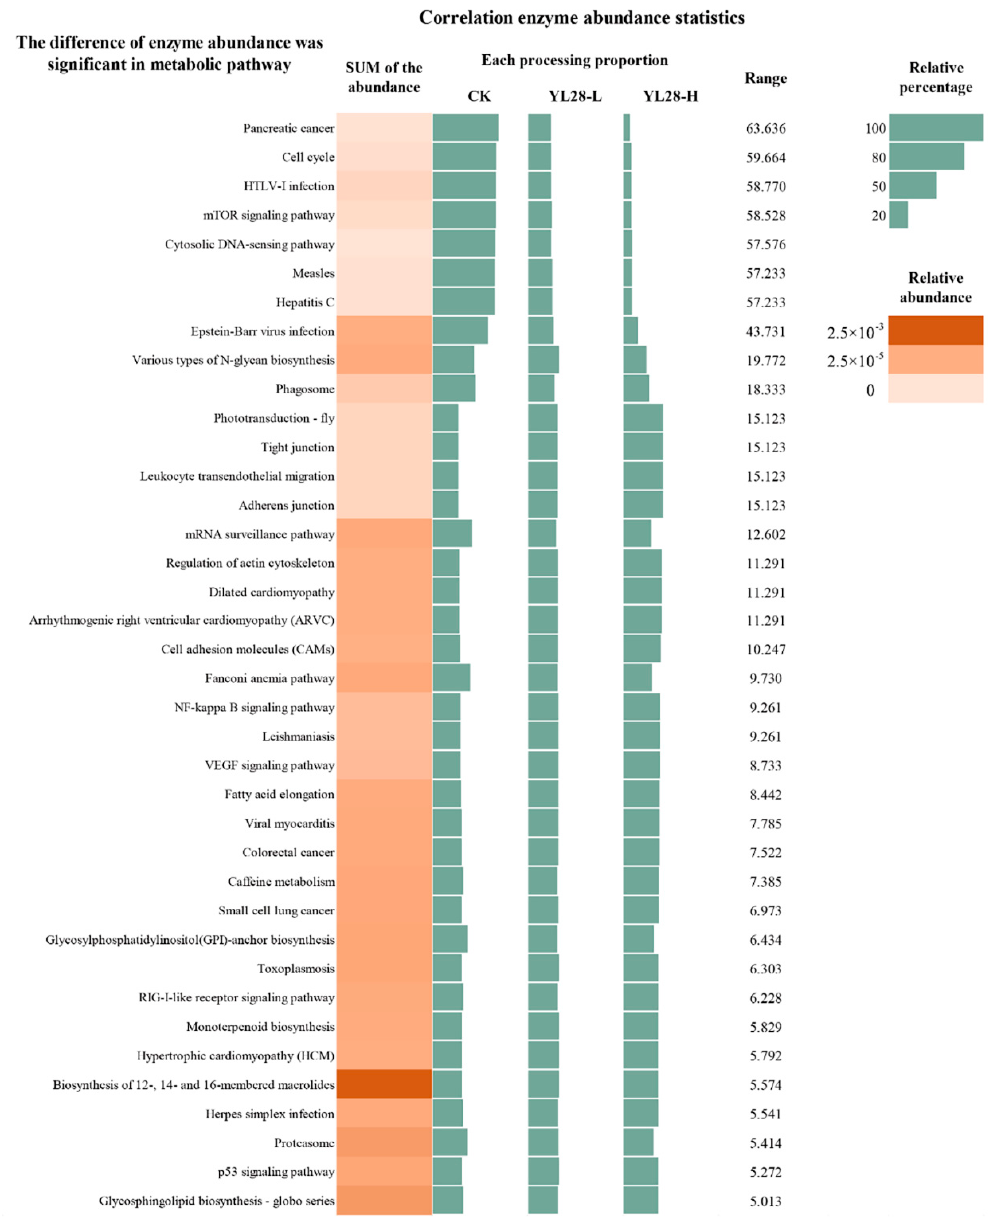
(0.063%) and proteases (0.056%). The biosynthesis of sugar-based phosphatidylcholine extreme difference was less than 6.97% within groups. The enzyme abundance of other metabolic pathways was less than 0.02% (Figure